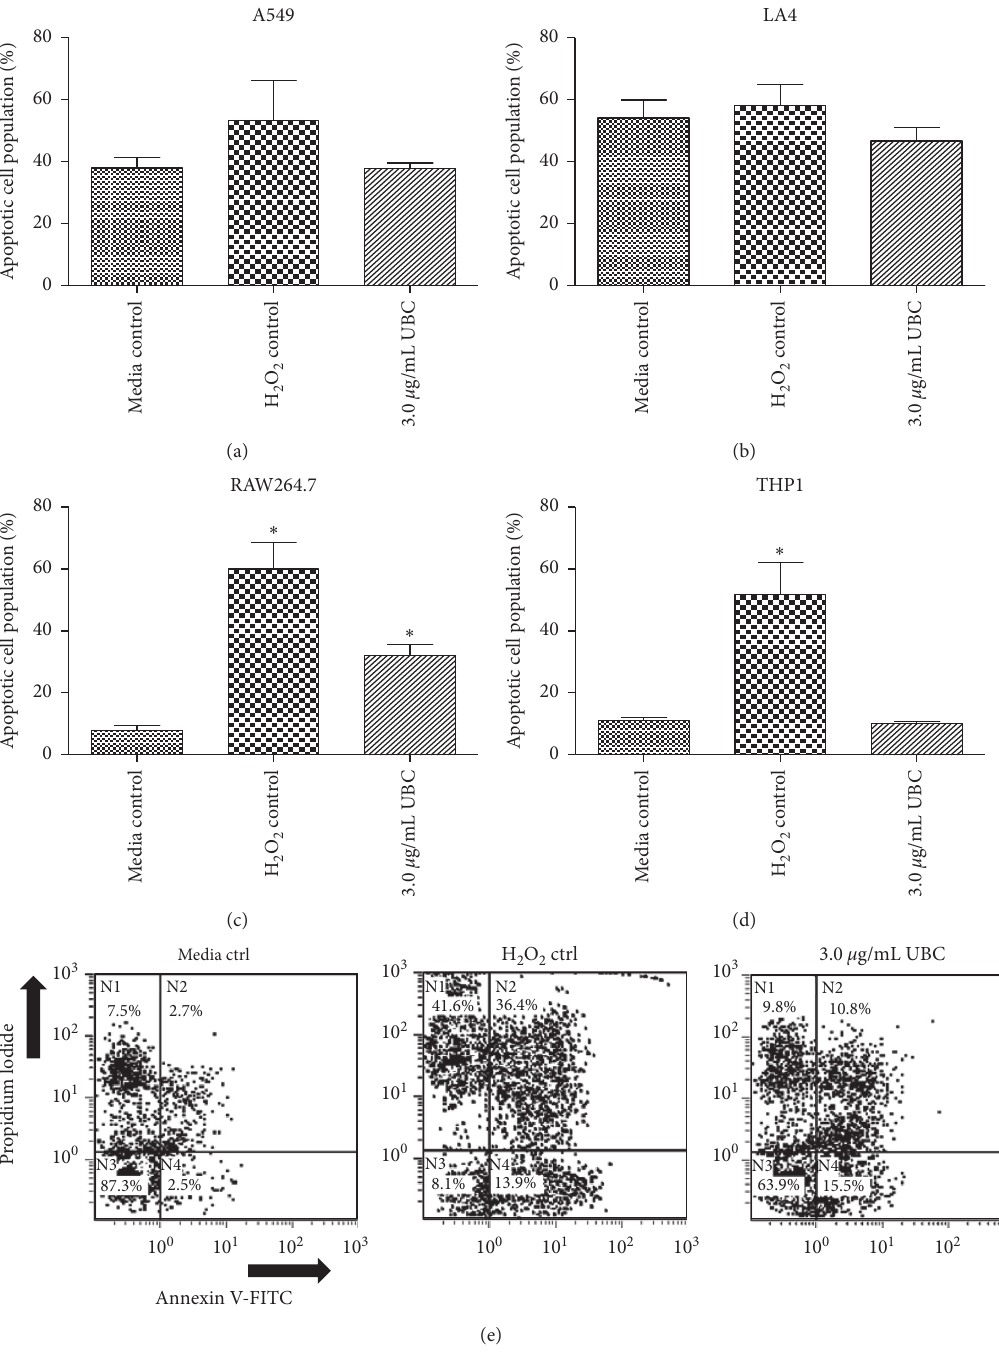
Figure 3: UBC induces low to moderate apoptotic conditions, as shown by FITC-Annexin V/PI costaining. All cells were seeded on day zero then treated with three concentrations of UBC, as described in Methods. Following day 9, the cells were harvested and apoptosis/necrosis was assessed by flow cytometry after double staining with FITC-Annexin V and PI. Percentage of apoptotic cells are shown for each of the cell lines ((a), (b), (c), and (d)) upon treatment with the highest UBC concentration. A representative double-parameter flow cytometry dot- plot for RAW 264.7 is presented (e) where N1 shows necrotic cells that are PI-positive, but FITC-Annexin V negative; N2 depicts late apoptotic cells that are FITC-Annexin V and PI double-positive; N3 specifies unstained viable cells with intact membranes that are FITC- Annexin V and PI double-negative; N4 contains early apoptotic cells that are PI-negative yet FITC-Annexin V positive. Dots (or events) show density quadrants. Low-density regions are designated in a lighter number of events, high-density regions in the darker number of events. Approximately 10,000 events were acquired per sample. Data determined as the mean of six replicates and is representative of three independent experiments. Statistically significant at ∗ p < 0 . 05 in comparison to media (untreated)